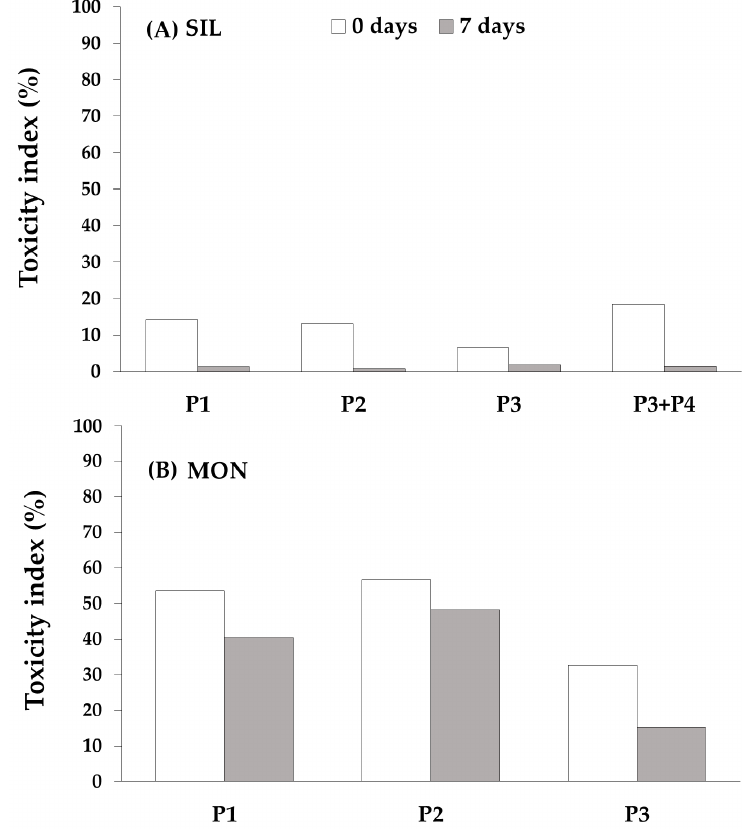
Figure 5. Integrated Toxicity index values at 0 and 7 days obtained from SIL ( A ) and MON ( B ) soil mesocosms treated with the various foaming agents. SIL: sandy-silty-clay soil; MON: gravel in a sandy-silty soil. P1, P2, P3, P4: foaming agent products.